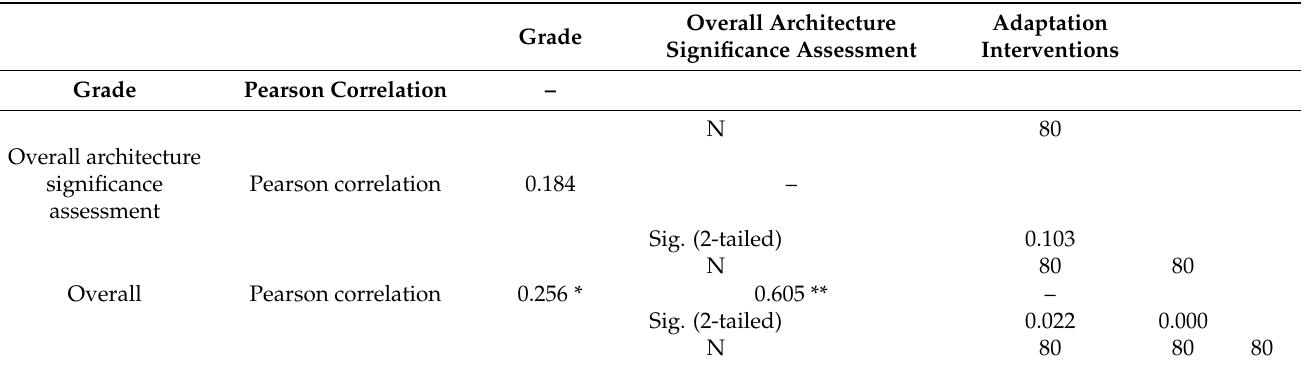
Table 3. Correlation between the overall architectural significance assessment of the building and adaptation intervention level and